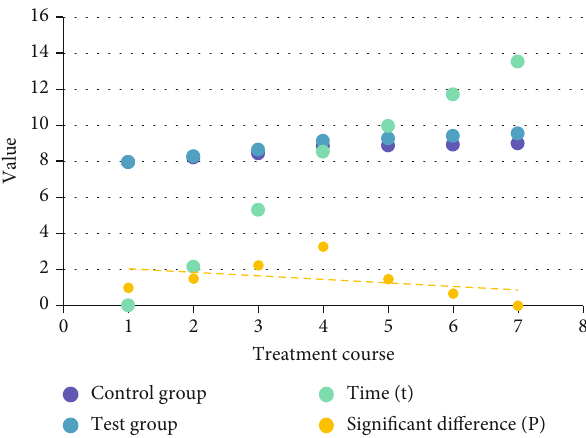
Figure 2: Comparison of the overall quality of life between the two groups of patients before and after intervention.